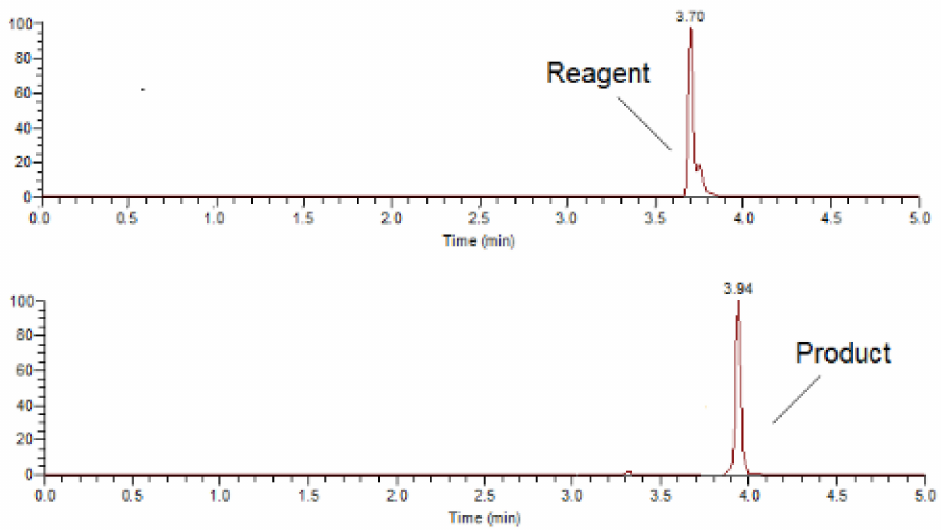
Figure 4. Representative chromatograms of the derivatization reagent ( top ) and the derivatized pregabalin ( bottom ).